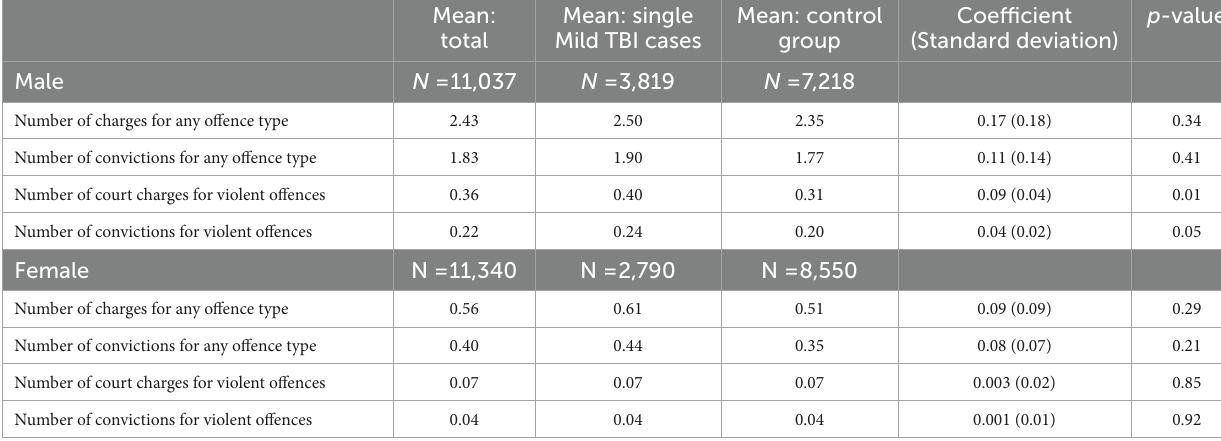
TABLE 3 Criminal behaviour outcomes by gender excluding prior